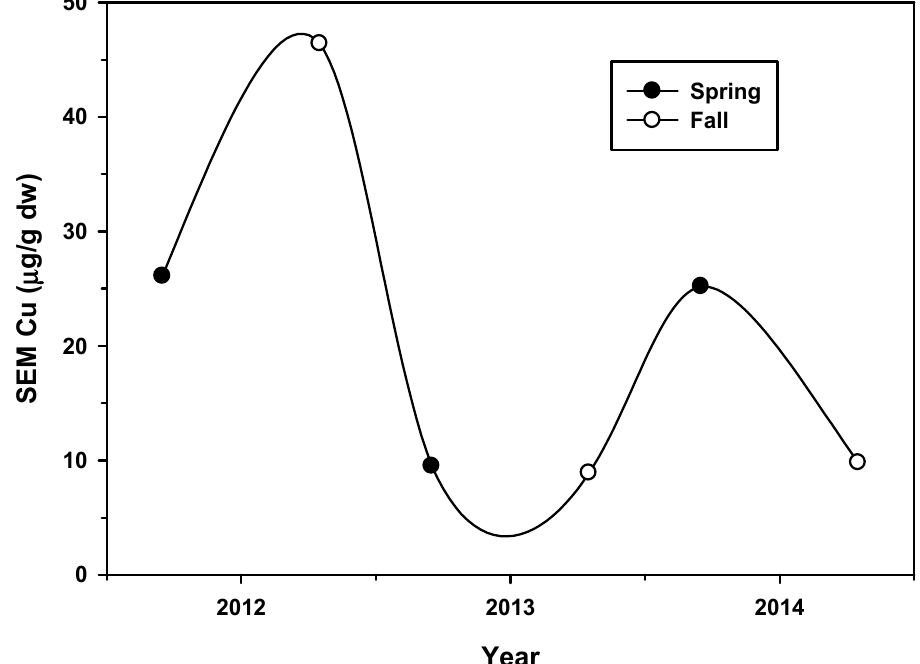
Figure 9. SEM copper concentrations (µg/g dry wt) from spring and fall sediment sampling at Cache Slough site CS-08 for the years 2012, 2013 and 2014.